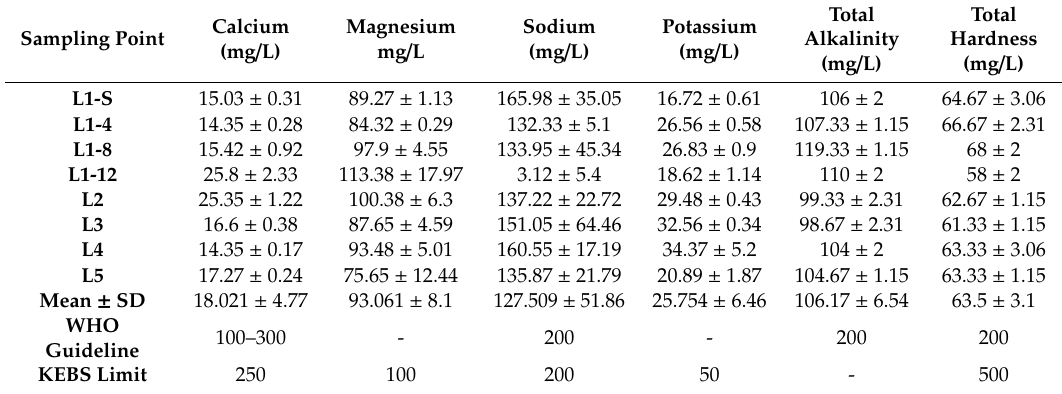
Table 7. Concentration of chemical parameters in Rungiri quarry reservoir in August 2019.